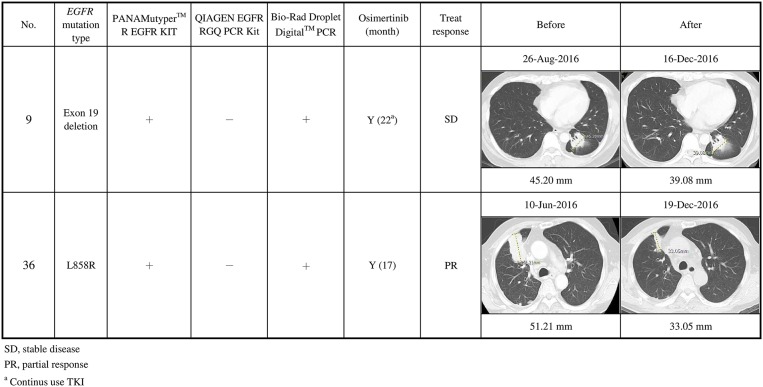
Clinical characteristics of secondary EGFR T790M mutations not detected using the in-house method, and their responses to osimertinib treatment (n = 2). Case 9 stabilized, and case 36 partially responded after osimertinib treatment.